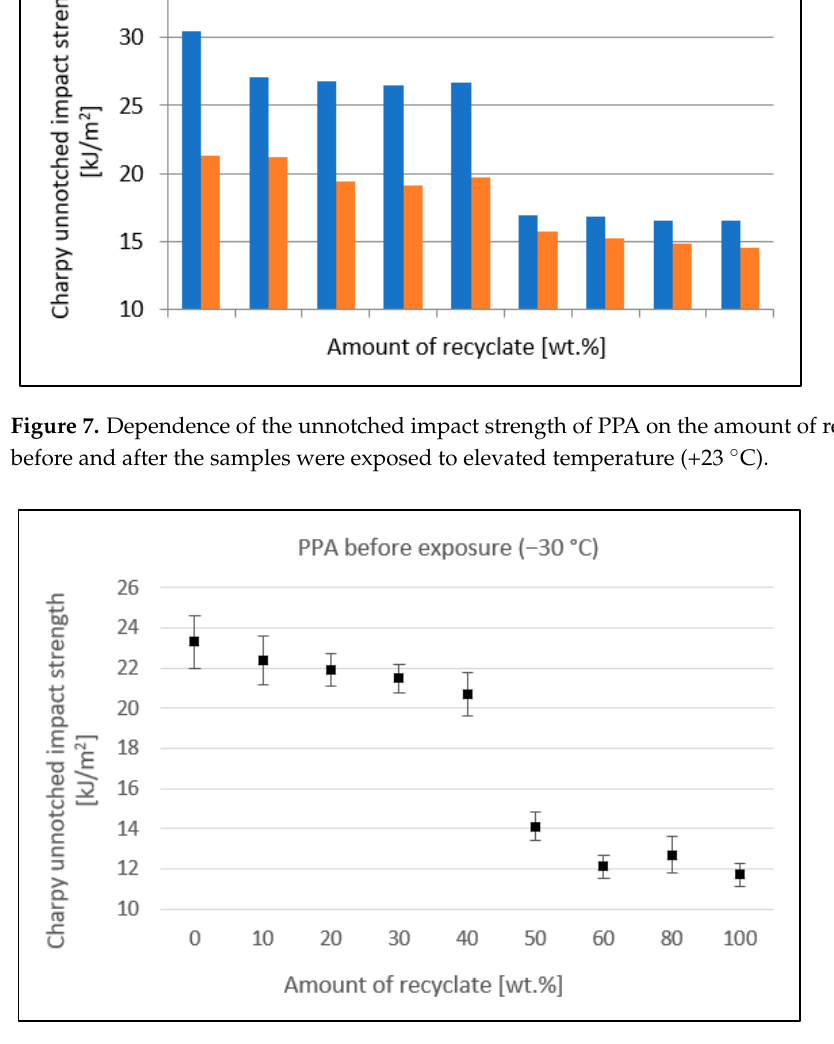
Figure 7. Dependence of the unnotched impact strength of PPA on the amount of recycled material before and after the samples were exposed to elevated temperature (+23 °C).